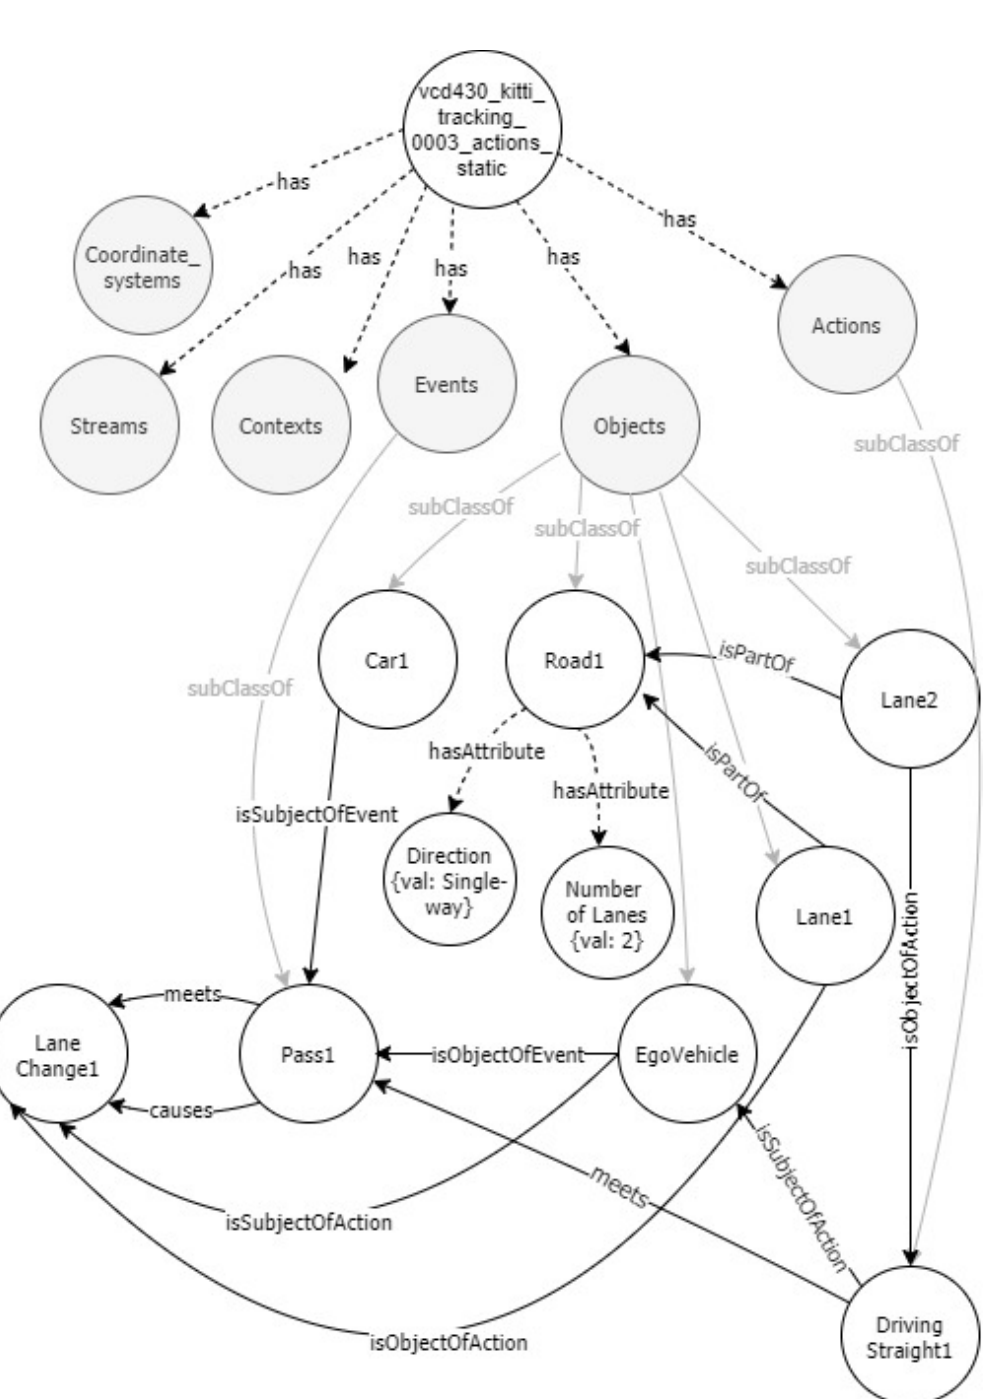
Figure 11. Part of the representation as a graph of the KITTI dataset example scenarios’ static ele- ments.